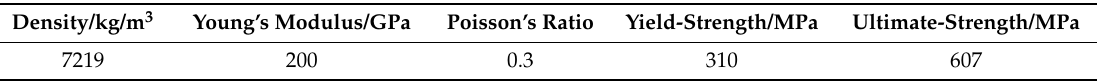
Table 1. Material properties of Q235 steel.